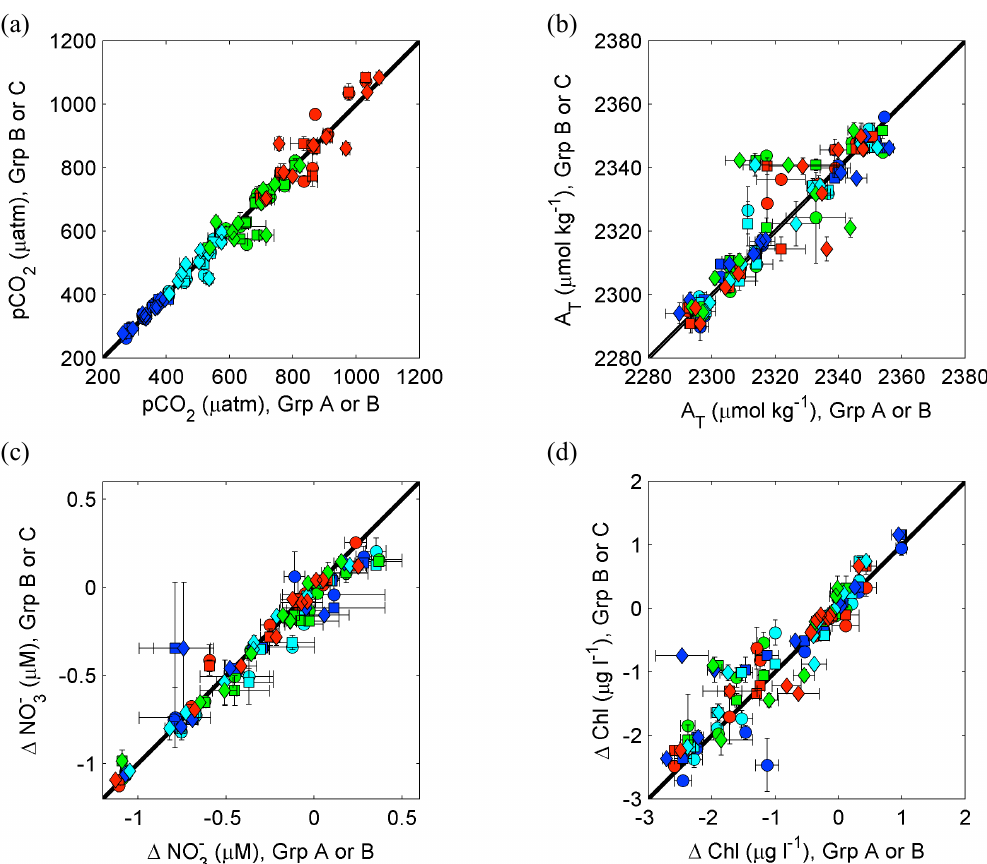
Figure 4. Comparison of variables measured across the three parallel sets of triplicate bottles (grps. A, B and C) for all main experiments: p CO 2 (µatm) (a) , A T (µmolkg − 1 ) (b) , change in nitrate concentration from initial condition (µmolL − 1 ) and (c) change in Chl a from initial condition (µgL − 1 ) (d) . Plotted values are means ± 1 SE of triplicate bottles in all cases. Colour indicates target p CO 2 treatment (blue: ambient; cyan: 550µatm; green: 750µatm; red: 1000µatm), with symbol shape indicating the following comparisons between groups: A vs. B (circles), A vs. C (squares) and B vs. C (diamonds).